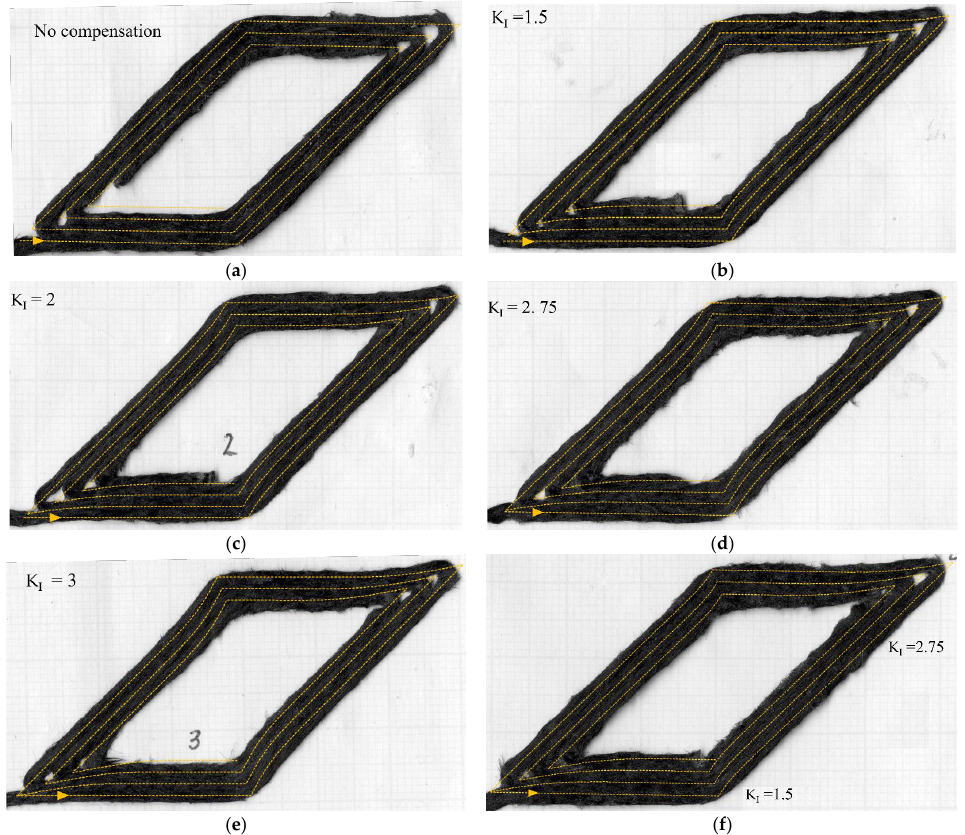
Figure 10. Parallelogram deposited rasters: ( a ) without compensation; ( b – e ) after path compensation with different levels of K I from 1.5 to 3, and ( f ) with varied K I ( K I =1.5 at 45°, 2.75 at 135° turning angle).